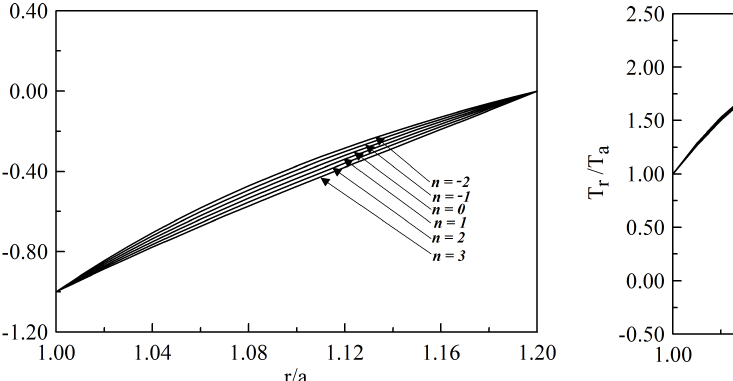
Figure 41: Radially distributed temperature